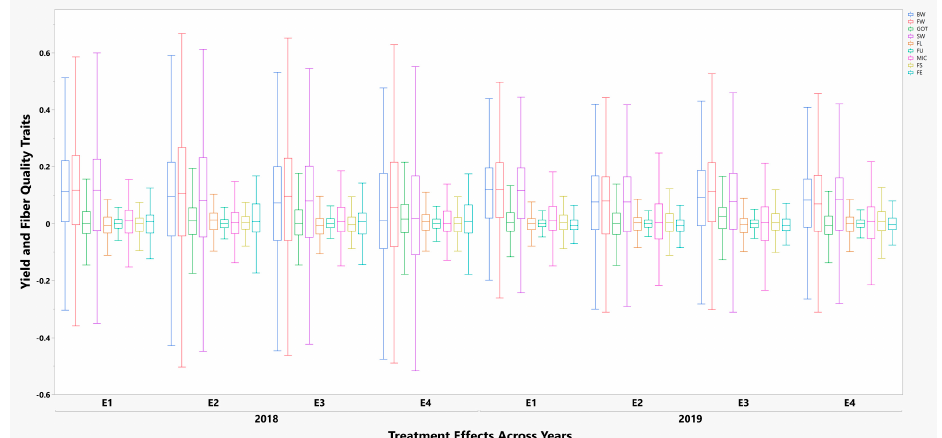
Figure 1. Distribution of four treatment effects of subtending leaf removal on fiber quality and yield related traits among 355 upland cotton accessions across years 2018 and 2019. Legends on the top right in different colors depict nine evaluated phenotypic traits.